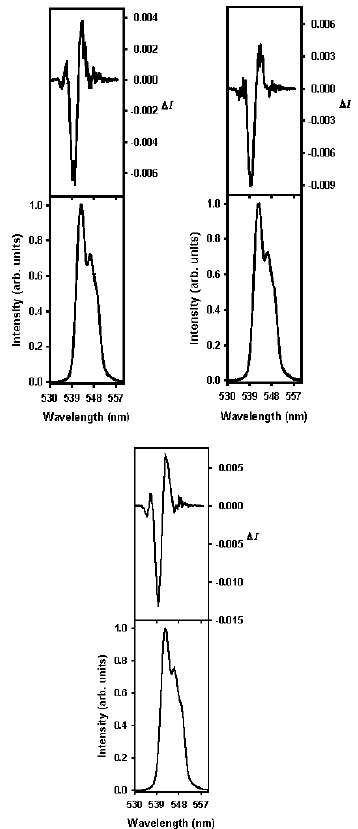
Figure 6. Circularly polarized luminescence (CPL) (top curves) and luminescence (lower curves) spectra for the 5 D 4 → 7 F 5 transition of [Tb(DPA) 3 ] 3− with 40 equiv. L -serine for 100:0 H 2 O ( left ) and 90:10 H 2 O:THF ( right ).